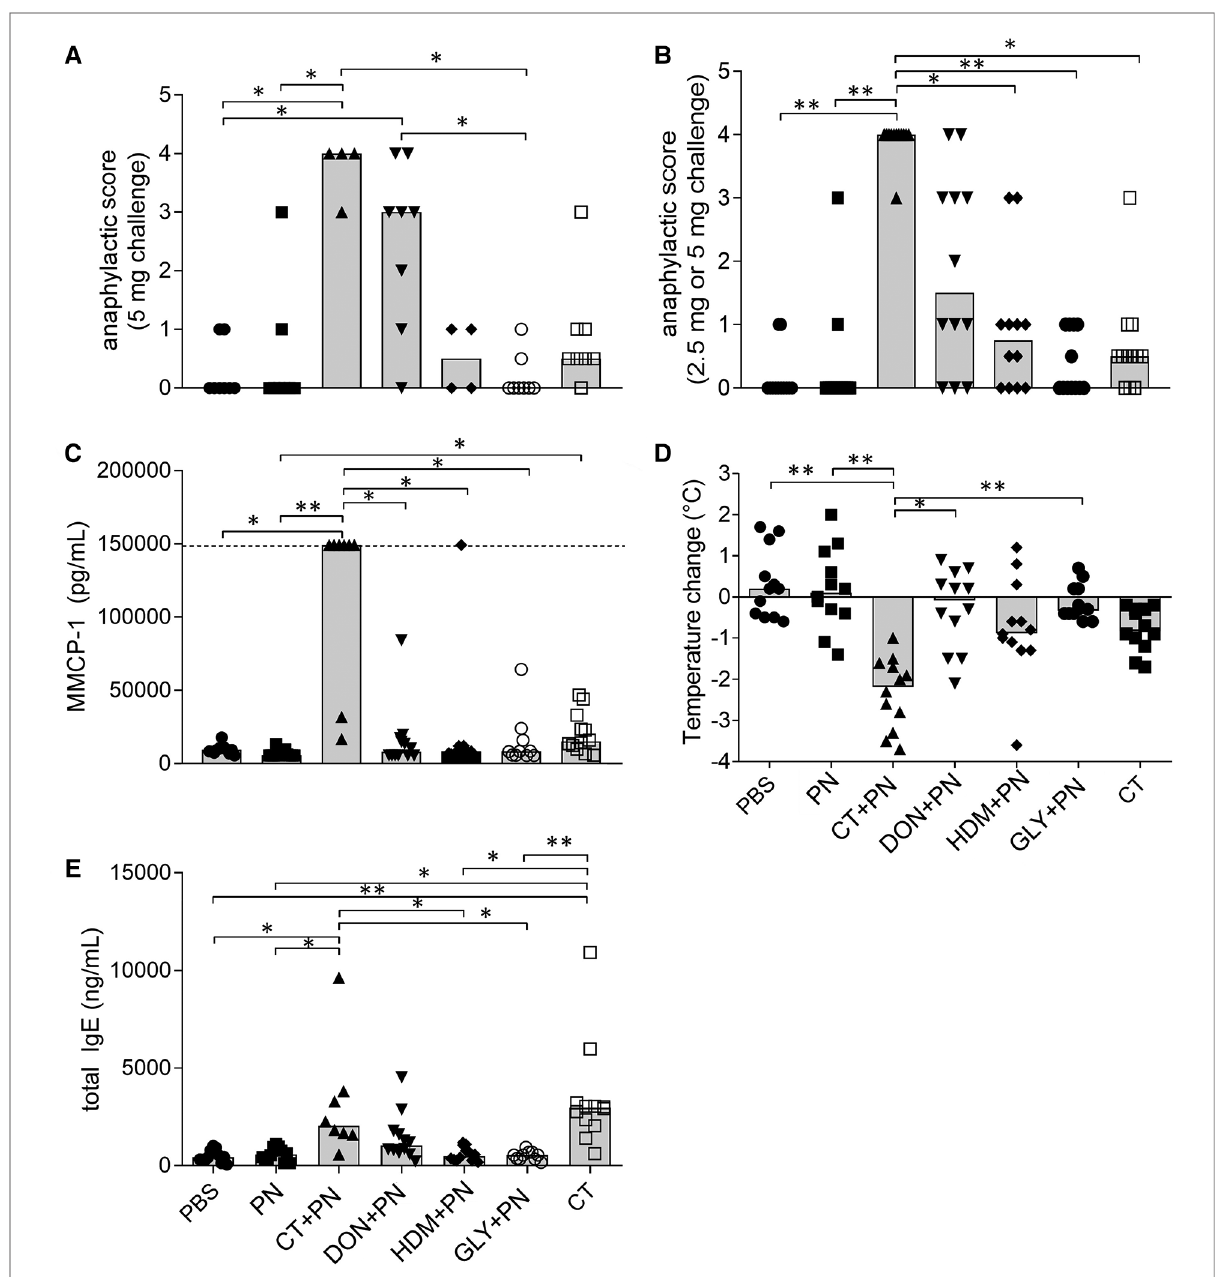
FIGURE 2 Anaphylaxis and sensitization after repeated immunizations with peanut extracts. ( A ) Anaphylactic score after i.p. challenge of 5 mg PN ( n =8 in PBS, PN, PN+DON, PN+GLY and CT groups, n =4 in CT+PN and PN+HDM groups). ( B ) Anaphylactic score after i.p. challenge of 2.5 or 5 mg PN ( n = 12). ( C ) Murine mast cell protease 1 (MMCP-1) concentrations in serum collected 30 min after PN challenge (PBS, PN, PN+DON, CT, all n =12), PN+ CT ( n =8), GLY+PN ( n =10). Dotted line represents the upper assay detection limit. ( D ) Temperature-change over the fi rst 30 min after PN challenge ( n =12). ( E ) total IgE concentrations in serum collected after PN challenge (PBS, PN, PN+DON, CT, n =12. PN+CT, n =8. GLY+PN, n =10). Stars denote statistically signi fi cant differences (* p <0.05, ** p <0.001) between groups. Columns denote the group median value while each symbol denotes the individual